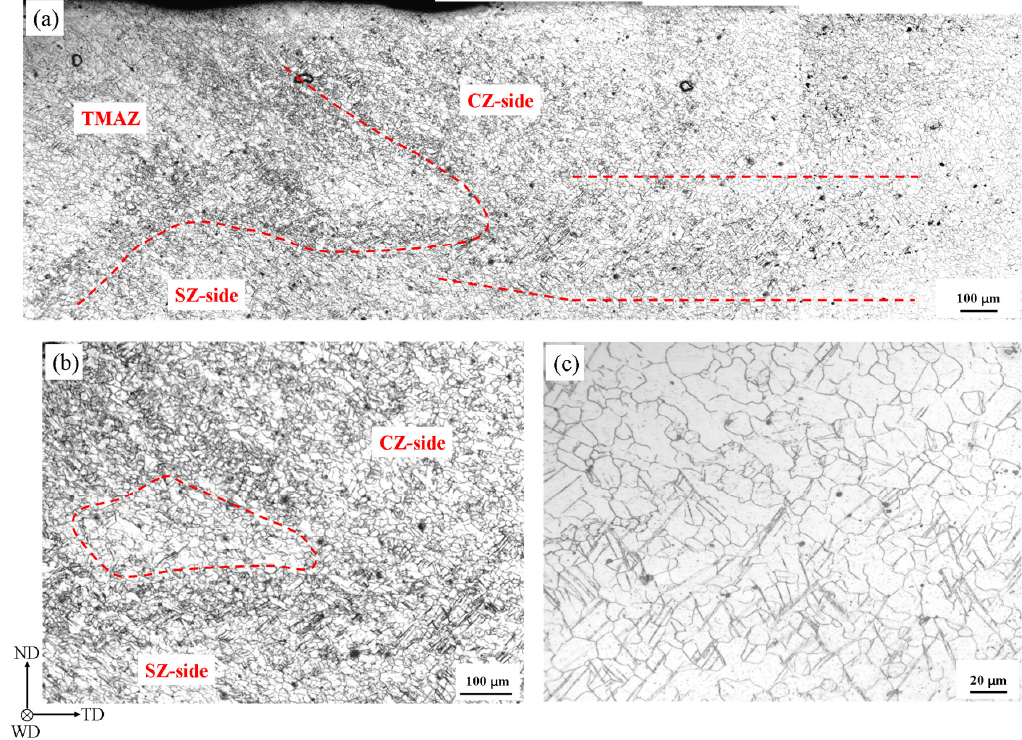
Figure 7. The metallographic photos at 90% UTS. ( a ) The metallograph near the triple junction region. The SZ side (SZ-side), CZ side (CZ-side) and TMAZ were marked with the red words in the relative regions in ( a , b ). The twin band was marked between two red dotted lines in ( a ). The partial enlarged details on the left of and in the right end of the twin band were shown in ( b , c ), respectively. Materials 2019 , 12 , x FOR PEER REVIEW